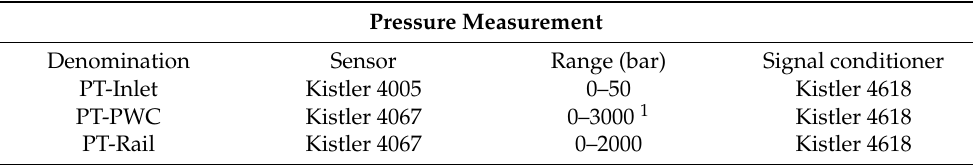
Table 2. Instrumentation features.